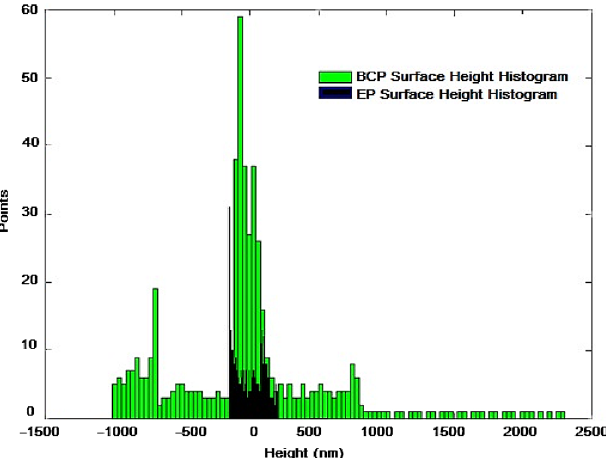
FIG. 2. Frequency distribution of height difference from mean after BCP ( 100 (cid:1) m removal) or EP ( 50 (cid:1) m removal) both at 20 (cid:2) C . The total scanning point number is 262144. The bin for BCP is 25 nm and bin width for EP is 5